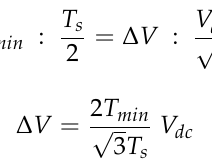
Figure 7. Current-unmeasurable areas (CUAs). ( a ) Sector 1; ( b ) reference-voltage vector hexagon. In addition, the amplitude of the CUAs ∆ V is obtained by Equation (3) [10].